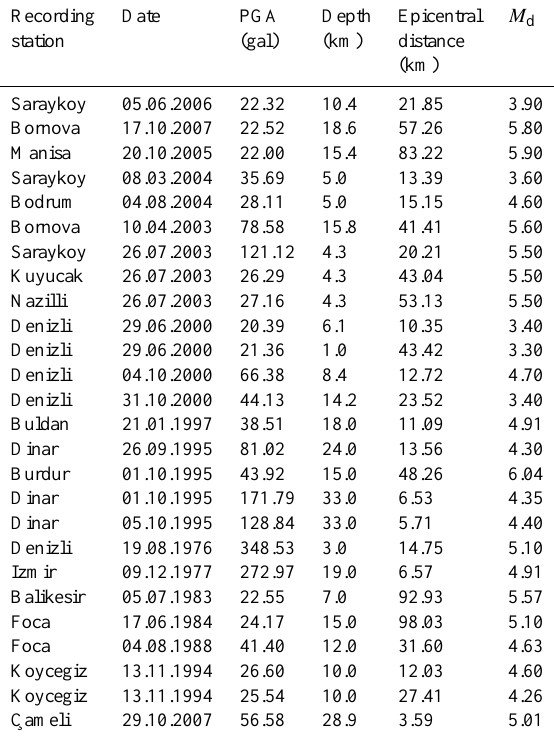
Table 2. Training dataset. Table 3. Test